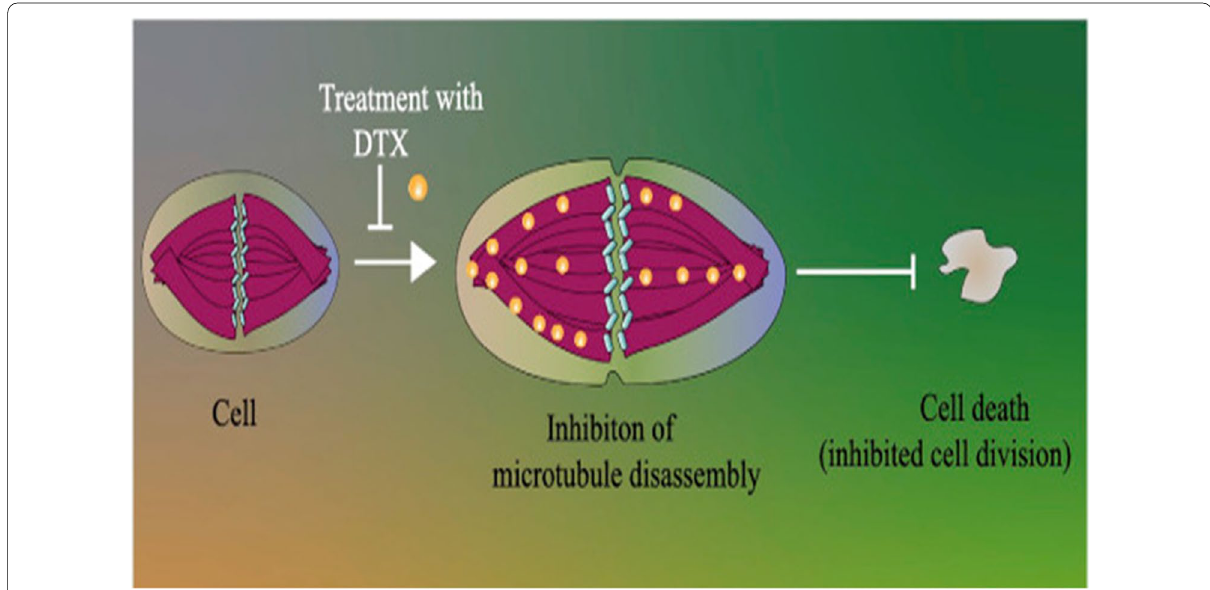
Fig. 2 Docetaxel is taken up by cancerous tissues with subsequent inhibition of microtubules disassembly, hence resulting in apoptosis of the cells (Wikipedia, accessed 17th May,